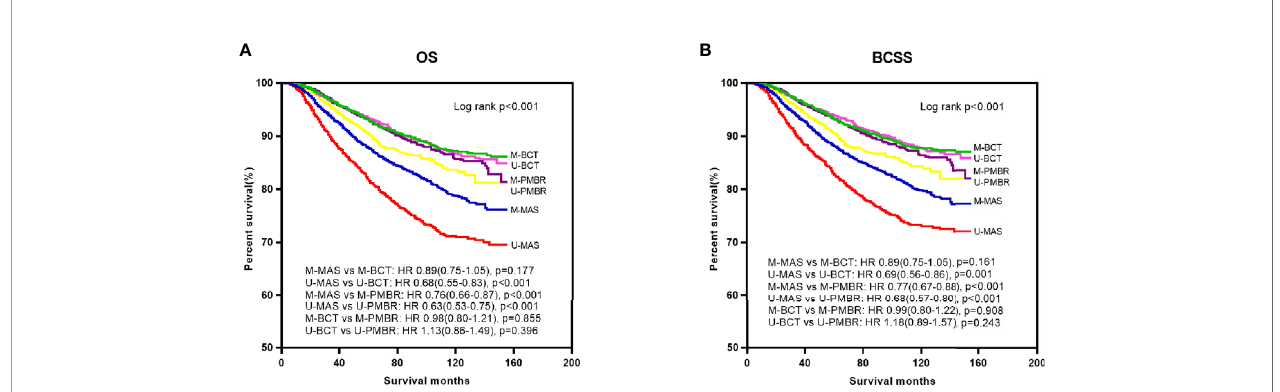
FIGURE 3 | Kaplan – Meier survival curves: OS (A) and BCSS (B) of young women with operable breast cancer according to surgical type and marital status. OS, overall survival; BCSS, breast cancer-speci fi c survival; M-MAS, married patients who underwent mastectomy; U-MAS, unmarried patients who underwent mastectomy; M-BCT, married patients who underwent breast-conserving therapy; U-BCT, unmarried patients who underwent breast-conserving therapy; M-PMBR, married patients who underwent post-mastectomy breast reconstruction; U-PMBR, unmarried patients who underwent post-mastectomy breast reconstruction; HR, hazard